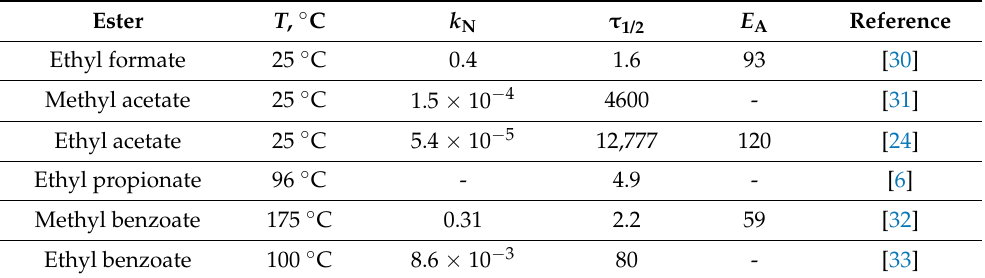
Table 2. The rate constant ( k N , days − 1 ), 1/2 hydrolysis ( τ 1/2 , days), and activation energy ( E A , kJ · mol − 1 ) for neutral ester